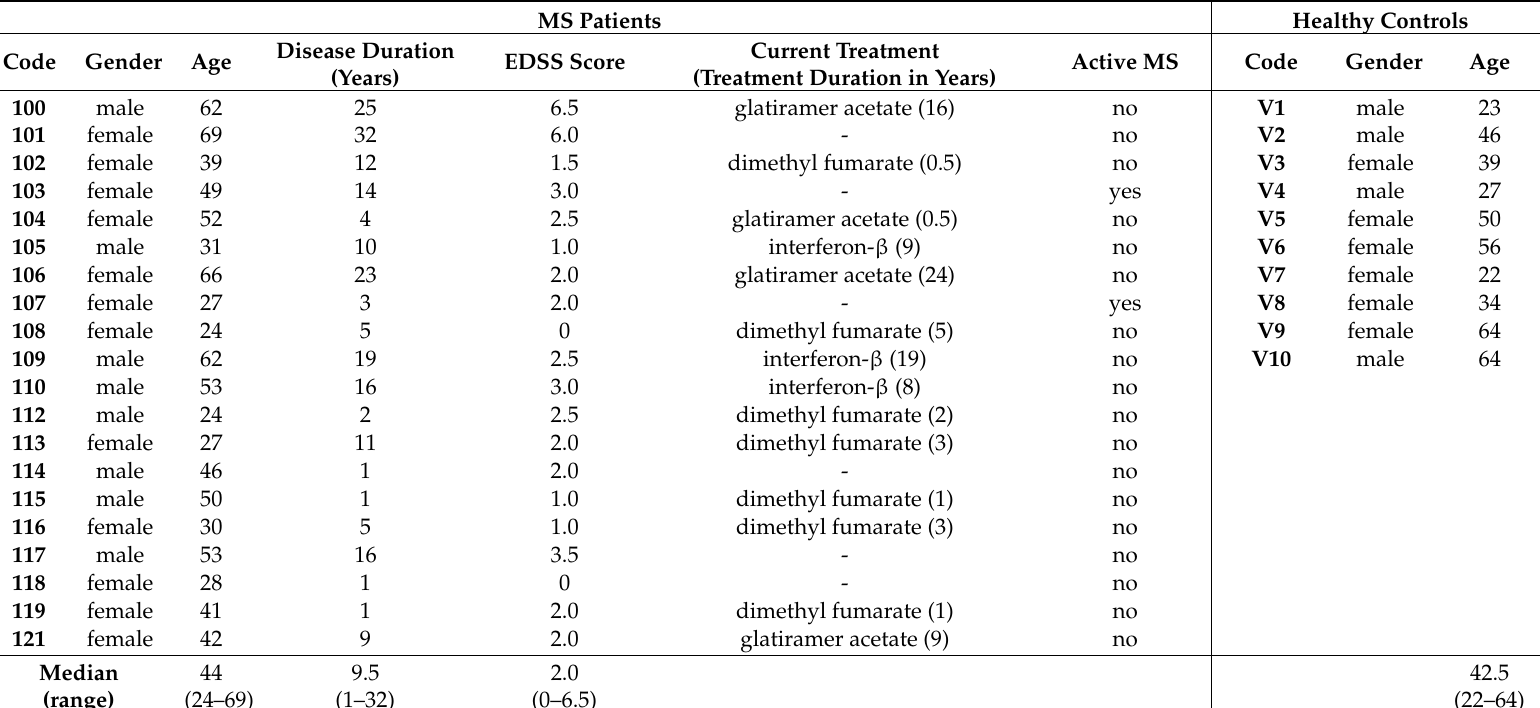
Table 1. Clinical details of the study subjects included into the